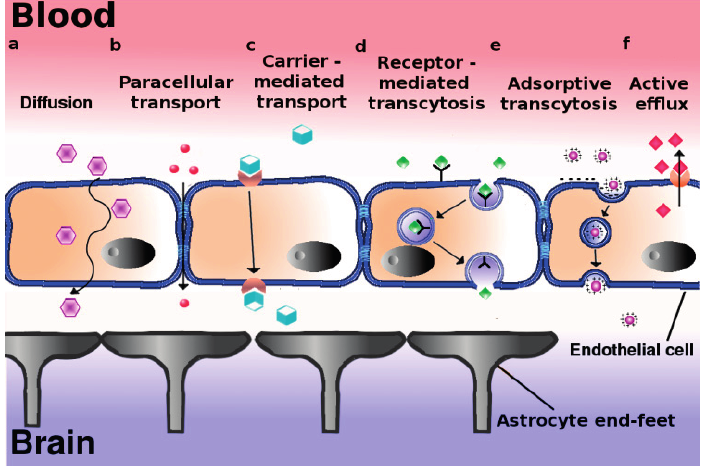
Figure 1. Proposed mechanisms of transport across the blood–brain barrier. The blood brain barrier consists in essence of a polarized layer of vascular endothelial cells, tightly attached to each other by means of tight junctions, and lined up by astrocytes. A variety of transcellular transport processes can be distinguished: ( a ) Diffusion, driven by a concentration gradient, mainly involving small hydrophobic molecules. This pathway represents the main entry route into the brain of current therapeutics; ( b ) Paracellular transport–limited to small water-soluble molecules; ( c ) Carrier-mediated transport, as occurs for e.g., glucose, amino acids, nucleosides, and therapeutics such as vinca alkaloids, azidothymidine etc. ; ( d ) Receptor-mediated transcytosis for peptidic signaling and regulatory molecules (insulin, leptin, interleukins), nutrients (iron, LDL); ( e ) Adsorptive transcytosis, presumably relying on transport of positively charged cargo (serum proteins) in a non-specific manner; ( f ) Proton pump efflux